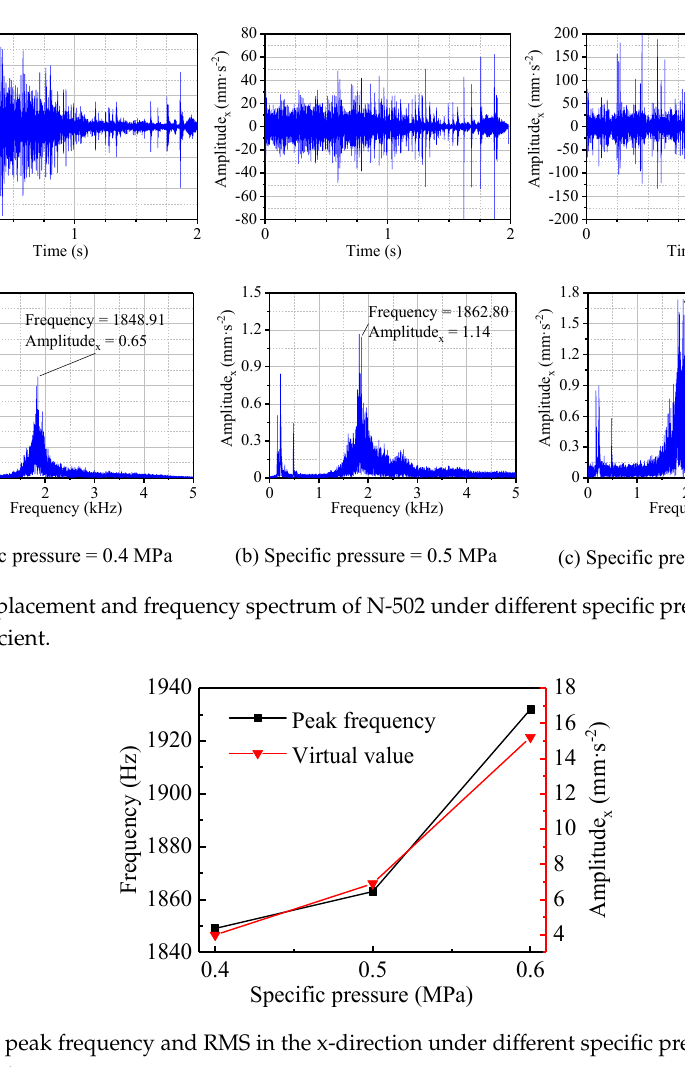
Figure 8. The peak frequency and RMS in the x-direction under different specific pressures with the μ 1 friction coefficient.